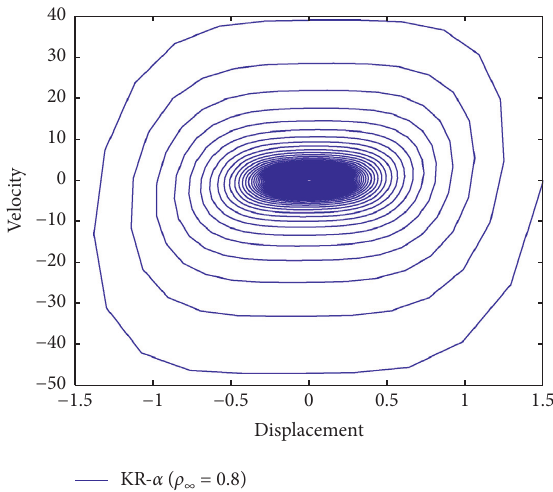
Figure 19: Phase portrait of the hardening spring calculated using � 0 . 8 ) when Δ t � T /20. the KR- α method ( ρ ∞